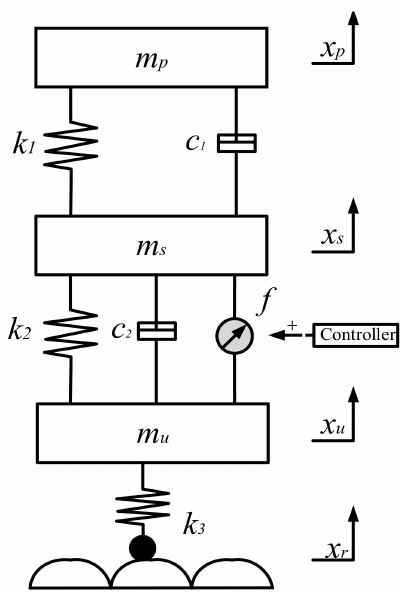
Figure 1. 3-DOF seat model with time-delay control